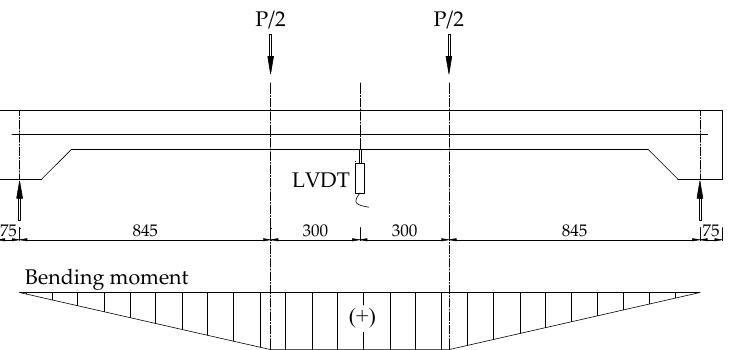
Figure 4. Four ‐ point bending setup for slab and the corresponding moment of the applied load. Figure 4. Four-point bending setup for slab and the corresponding moment of the applied